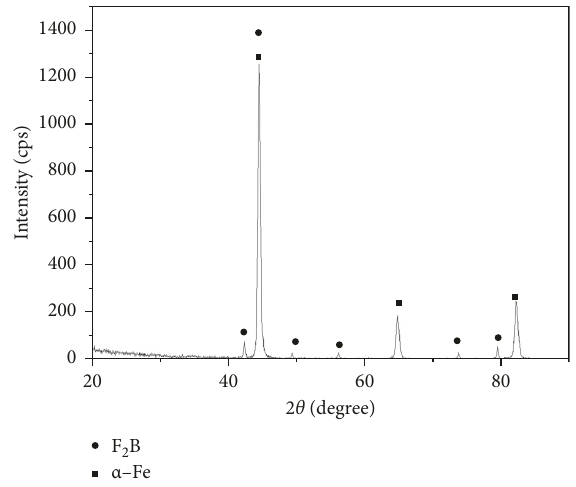
Figure 4: X-ray powder diffraction spectrum of Fe alloy.